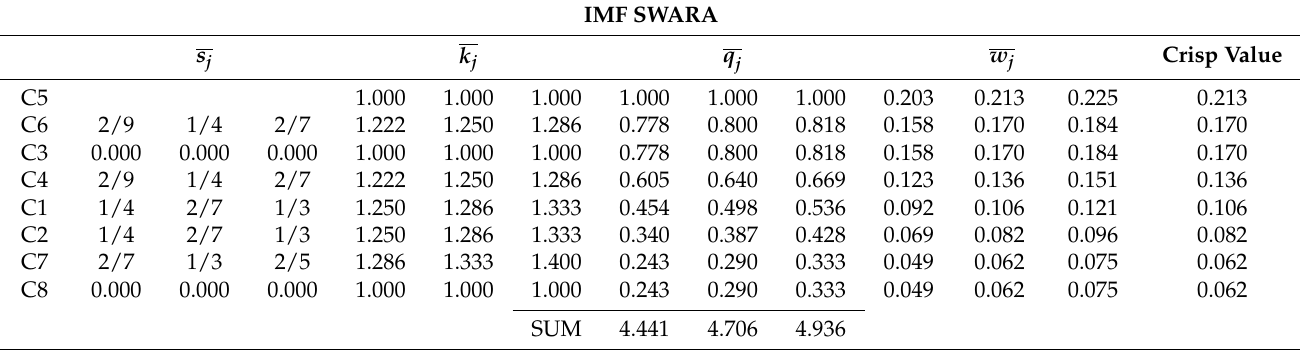
Table 7. Values of input and output significance in the considered model obtained by applying the IMF SWARA method. IMF SWARA s j k